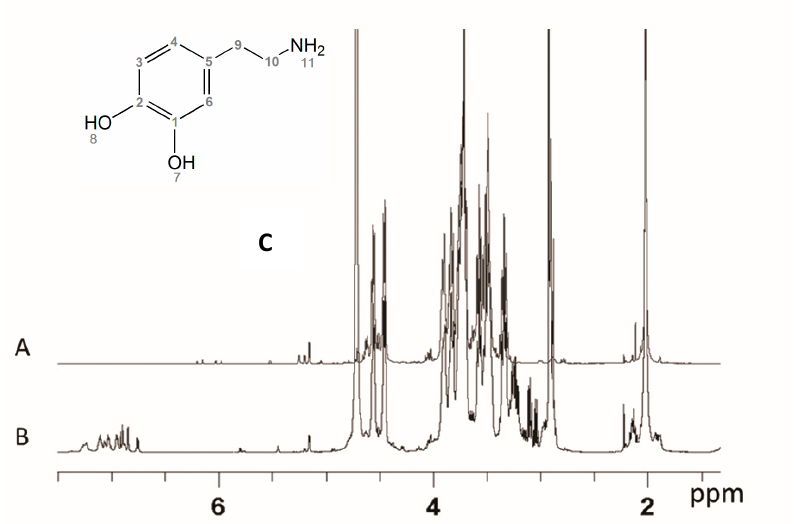
Figure 4. Proton spectra of HA ( A ) and HA-DA ( B ), ( C ) the DA chemical structure.